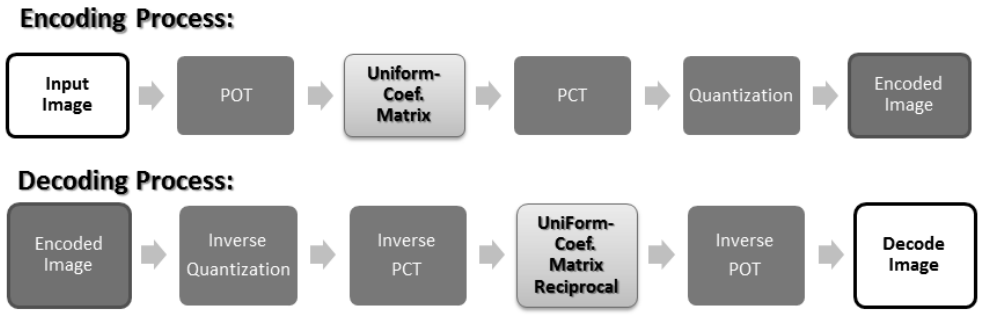
Figure 20. Improved JPEG-XR encoding/decoding